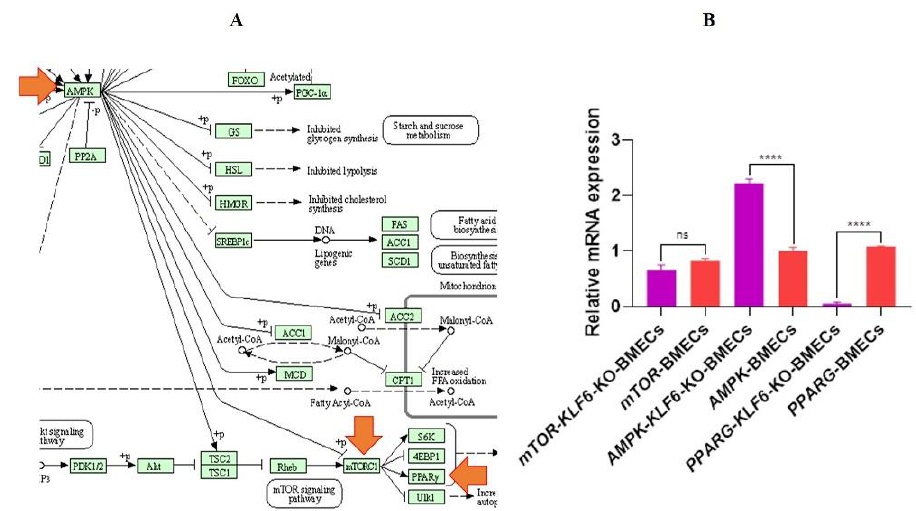
Figure 12. Analysis of lipid metabolism-related genes ( A ) The KEGG pathway of AMPK/mTOR/PPARG. Arrows point out the lipid metabolism-related pathways ( B ) The relative mRNA expression of AMPK/mTOR/PPARG in the KLF6 -KO-BMECs and normal BMECs. ns = non- significant, **** p < 0.0001.